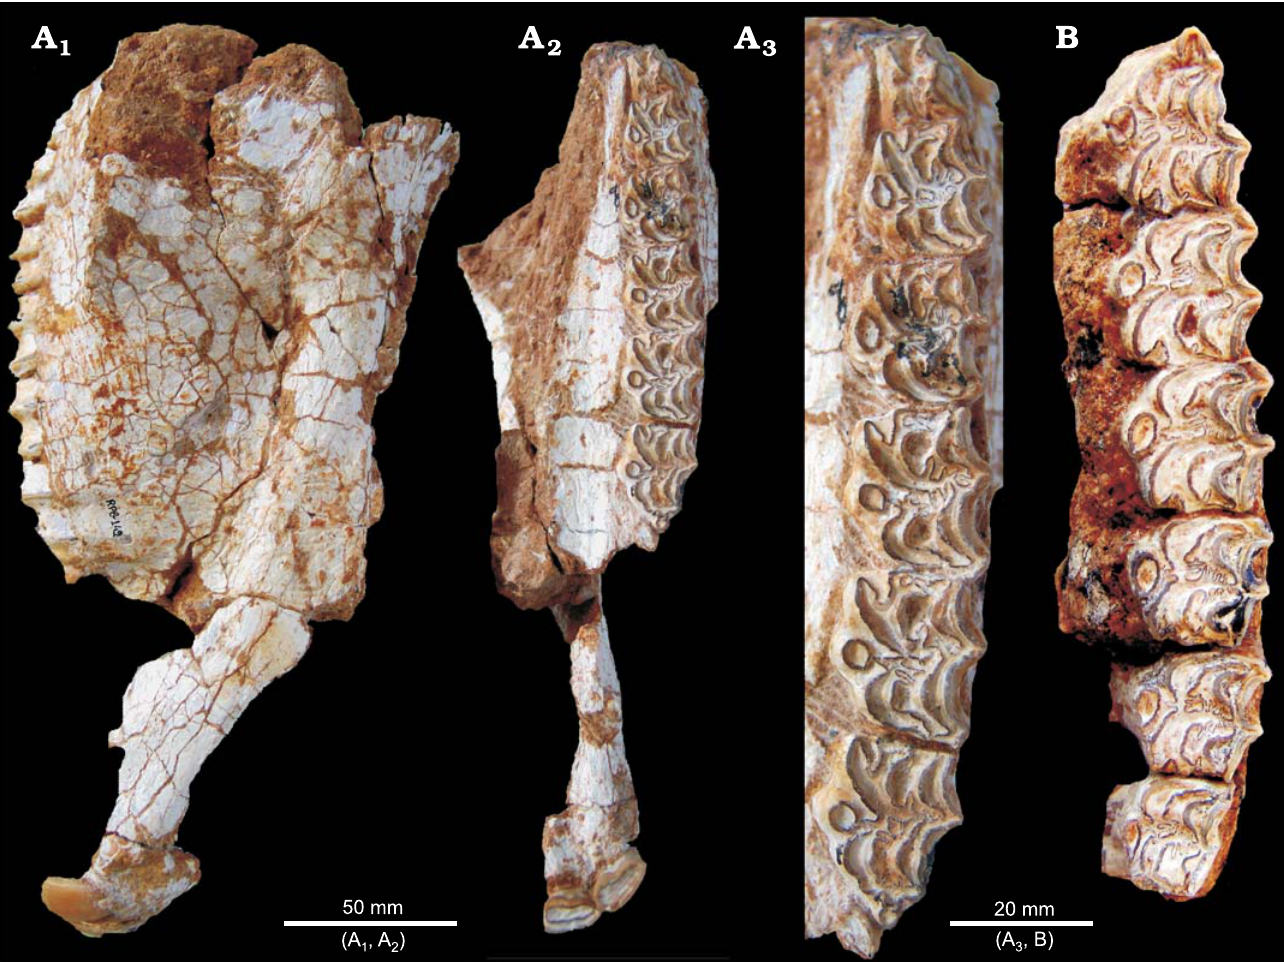
Fig. 2. Equid Hipparion macedonicum Koufos, 1984 from Ravin de la Pluie, Axios Valley (Macedonia, Greece), late Vallesian, MN 10 (Late Miocene). A . LGPUT RPl-142, right frontal part of skull in lateral (A 1 ) and occlusal (A 2 ) views, right tooth row in occlusal view (A 3 ). B . LGPUT RPl-37, left tooth row in occlusal